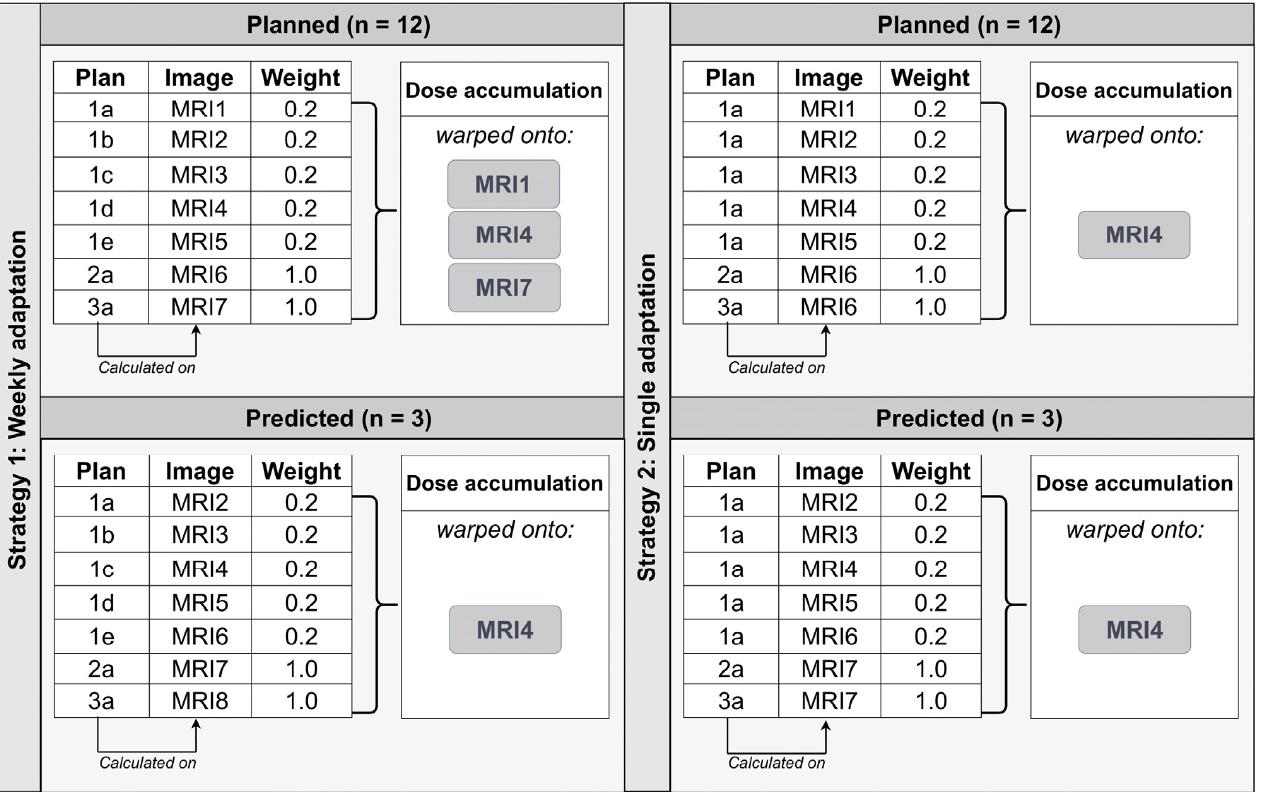
Figure 2. Overview of dose accumulation. Top left: cumulative planned dose of weekly adaptation using MRI1, MRI4 or MRI7 as the reference image. Top right: cumulative planned dose of one single adaptation obtained by recalculating plan 1a on MRI1–MRI5. Bottom left: cumulative predicted dose of weekly adaptation calculated for a subset of three patients obtained by recalculating each weekly plan on the MRI of one week later. Bottom right: cumulative predicted dose of one single adaptation calculated for a subset of three patients obtained by recalculating plan 1a on the images of one week later compared to the cumulative planned dose.